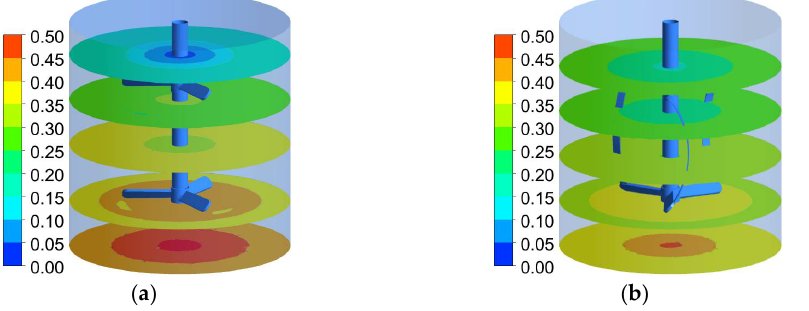
Figure 6. Contour plots of solid distribution for different impeller types. ( a ) DTBI; ( b ) DRFTBI. (Rotational speed: 120 rpm; solid loading: 30%; connection strap length: 1.2 H; plane: Z = 0 H, Z = 0.2 H, Z = 0.4 H, Z = 0.6 H, and Z = 0.8 H.)